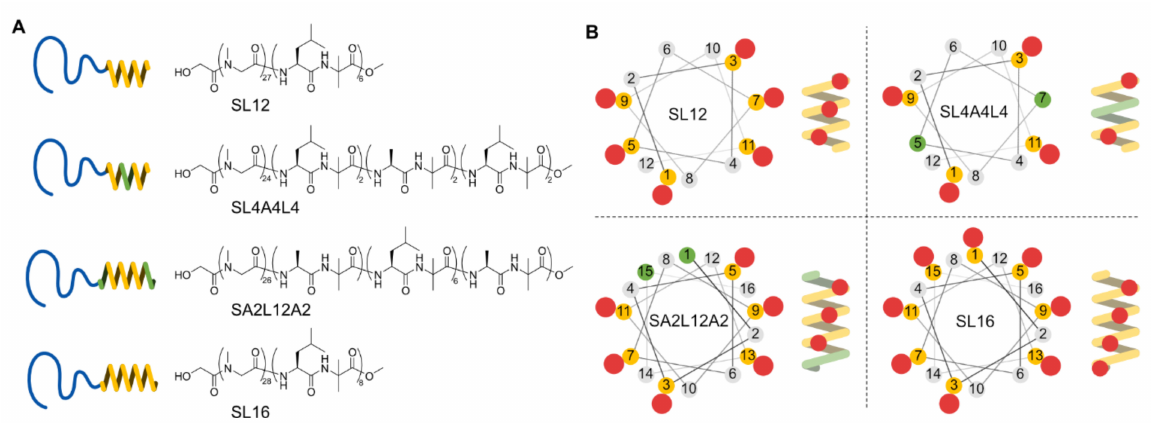
Figure 1. Schematic illustrations of chemical structures ( A ) and helical wheels ( B ) of amphiphilic polypeptides; SL12, SL4A4L4, SA2L12A2, and SL16. Yellow, green, and gray dots of helical wheels reflect the position of Leu, Ala, and Aib, respectively. Red dots indicate the positions of Leu side chains on the helix ( B ).